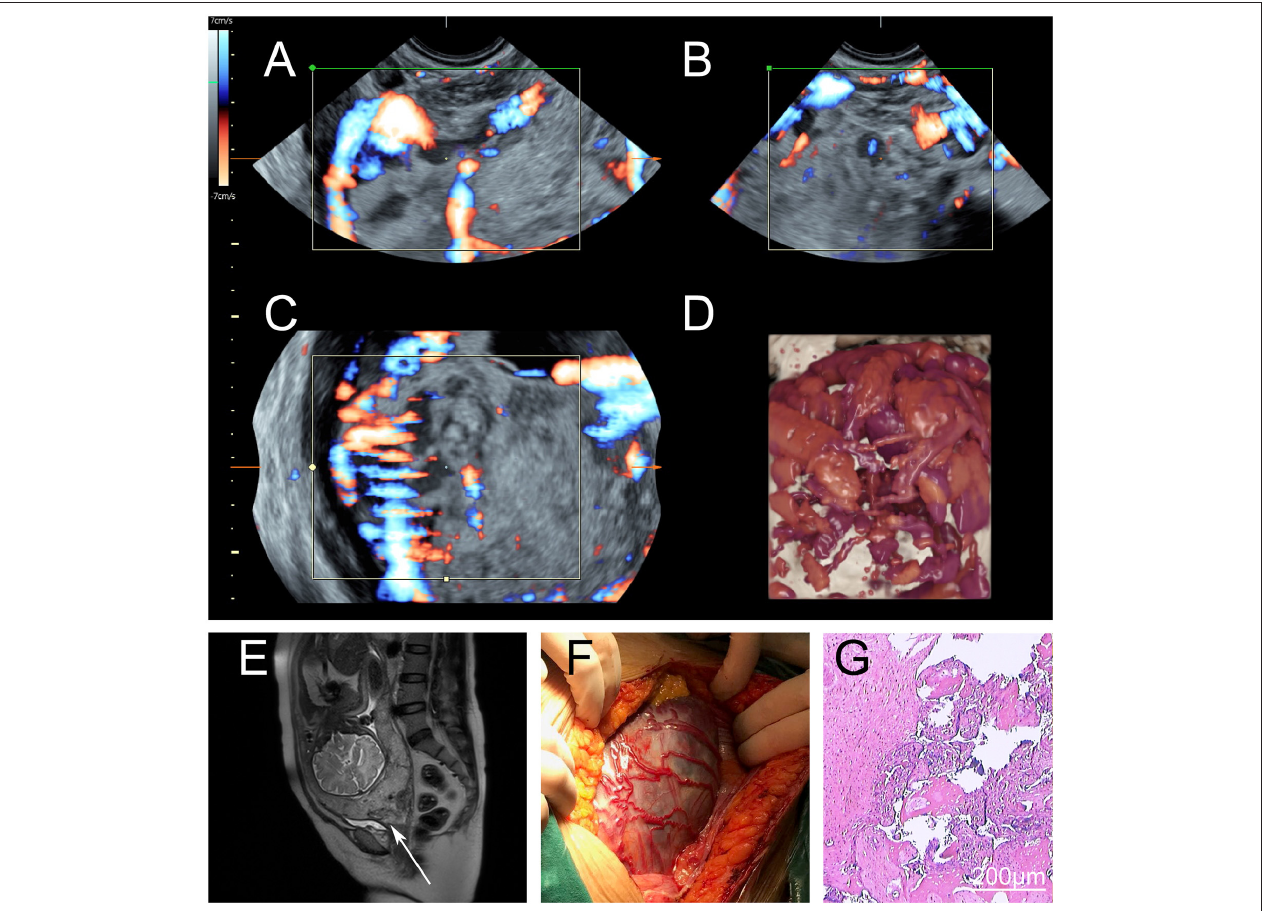
FIGURE 2 | Perioperative imaging of severe placenta accreta spectrum. (A–D) Preoperative magnetic resonance imaging of a severe placenta accreta spectrum patient. The placenta had invaded the myometrium and formed a large number of irregular blood vessels. During the operation, the deformed blood vessels were found under the serosa between the uterus and bladder. (A–C) Images of the different sections and blood flow. (D) Three-dimensional simulation image. (E) Preoperative magnetic resonance imaging. The cervix was invaded by the placenta (arrow). (F) Intraoperative observations. There were many dilated blood vessels in the lower uterus, and the placenta had invaded the serosa. (G) Postoperative pathological examination. The myometrium was invaded by